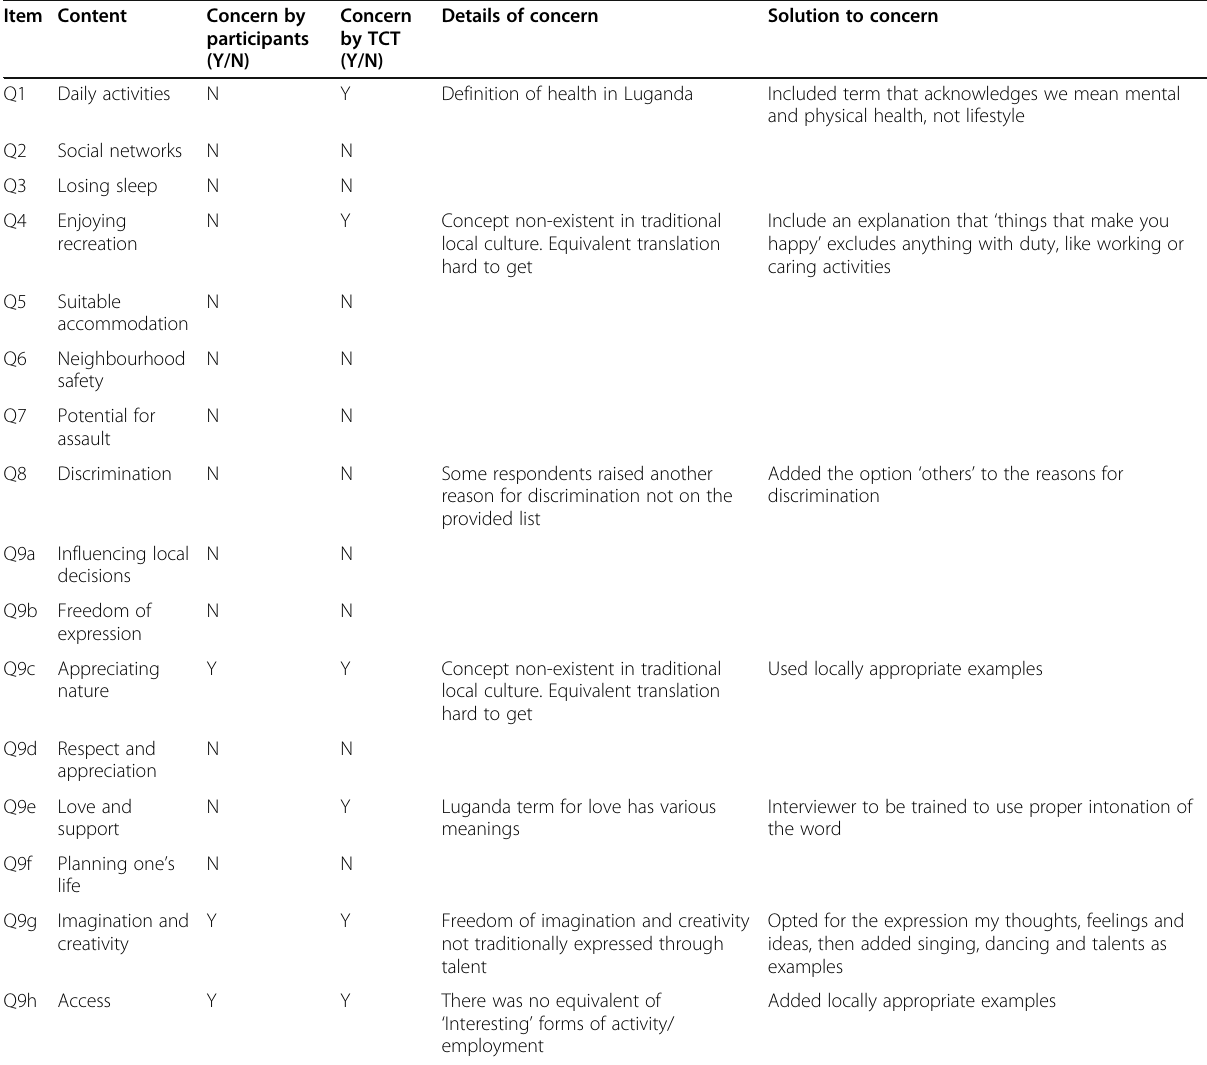
Table 2 Results of the pilot testing Item